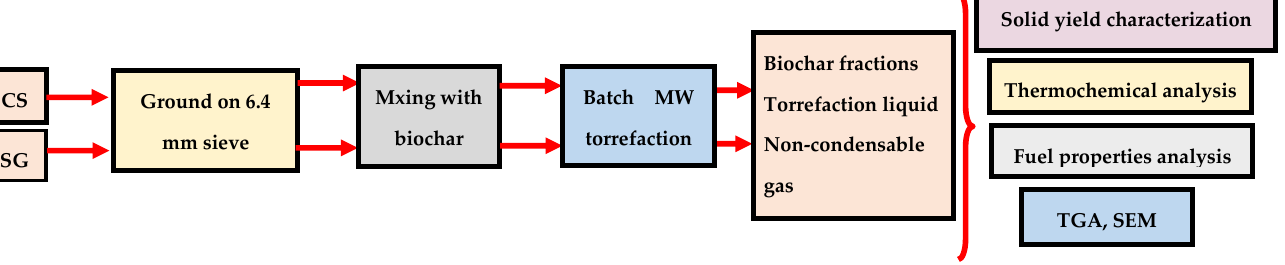
Figure 1. Experimental plan for microwave (MW) torrefaction of camelina straw (CS) and switchgrass (SG).